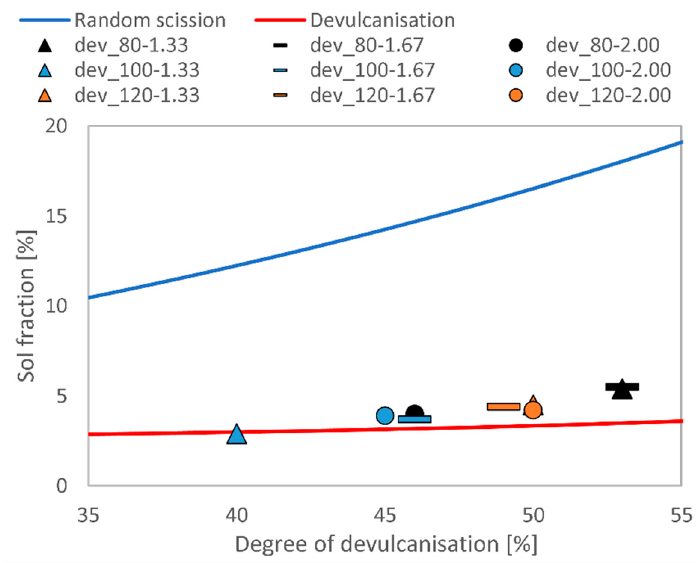
Figure 2. Horikx’s plot for the devulcanisates.